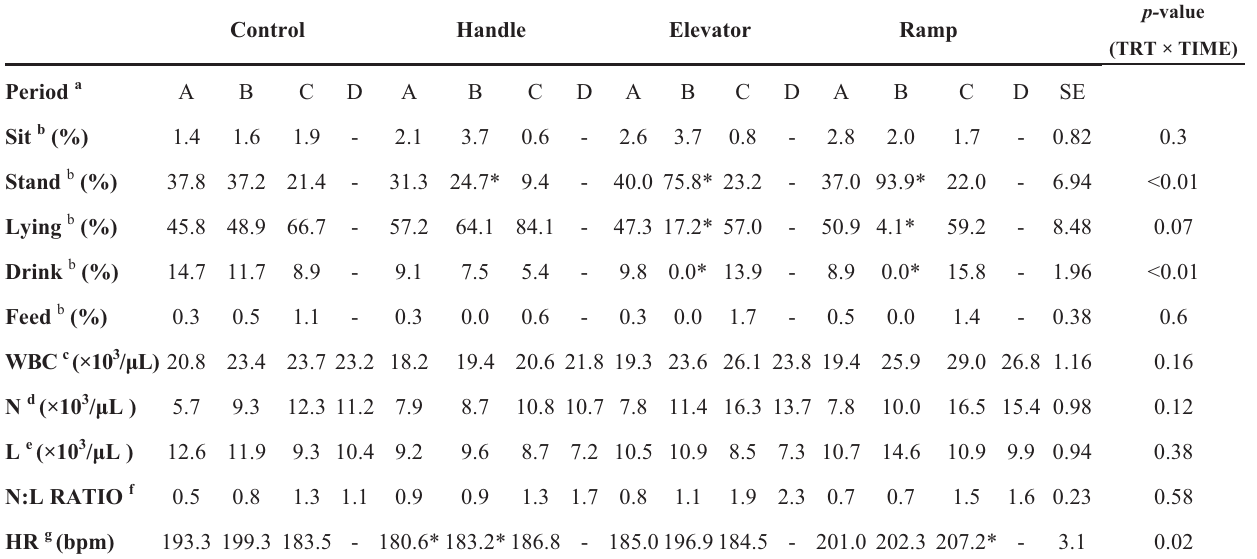
Table 1. Summary of the percentage of piglets displaying behaviors, the values of blood parameters and the heart rates of pigs in response to treatments before, during and after